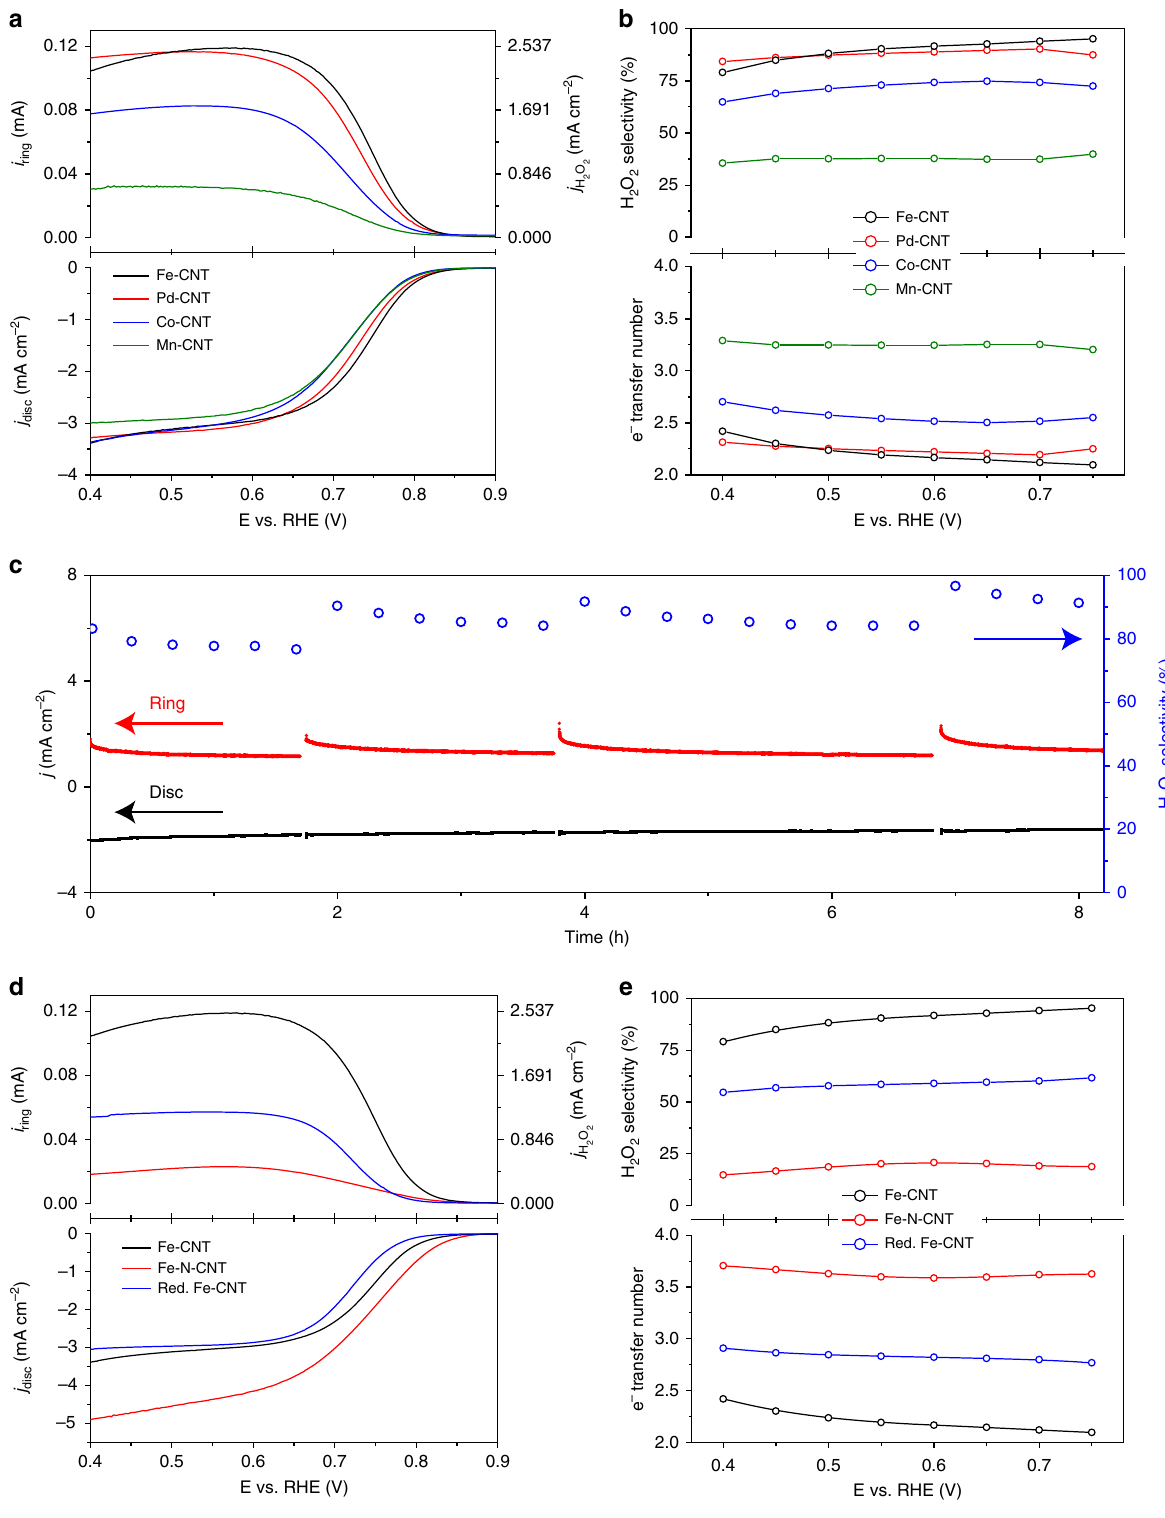
Fig. 3 ORR performance of M-CNT catalysts cast RRDE in 0.1 M KOH. a Linear sweep voltammetry (LSV) of CNT background and Fe-, Pd-, Co-, Mn-CNT catalysts recorded at 1600 rpm and a scan rate of 5 mV s − 1 , together with the detected H 2 O 2 currents on the ring electrode (upper panel) at a fi xed potential of 1.2 V vs. RHE. b Calculated H 2 O 2 selectivity and electron transfer number during potential sweep. c Stability measurement of Fe-CNT at a fi xed disk potential of ~0.71 V. The ring electrode was refreshed several times by rapid scan at negative potentials to remove the accumulated PtO x in continuous operation. d , e LSV and corresponding H 2 O 2 selectivity comparison on Fe-CNT, Fe-N-CNT, and forming gas reduced Fe-CNT (Red. Fe-CNT)